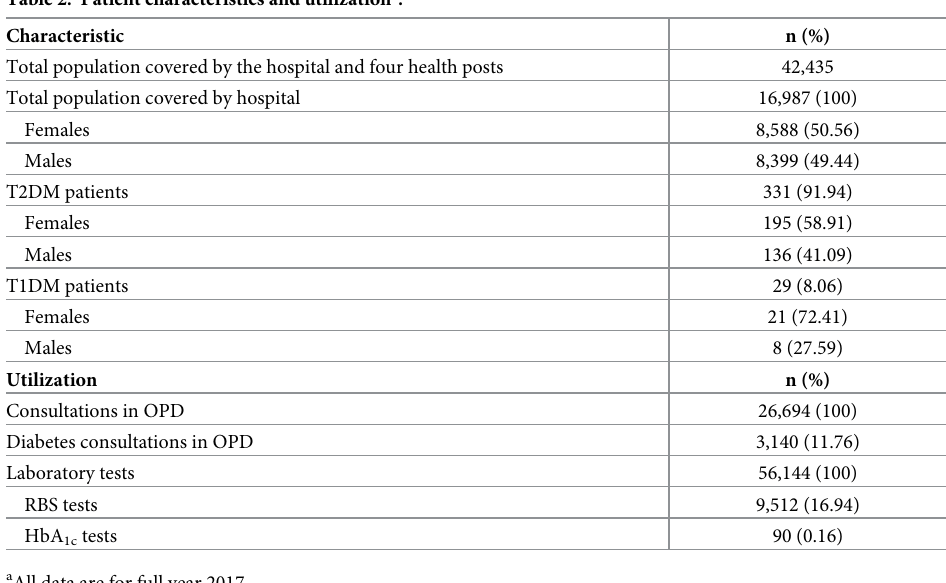
Table 2. Patient characteristics and utilization a